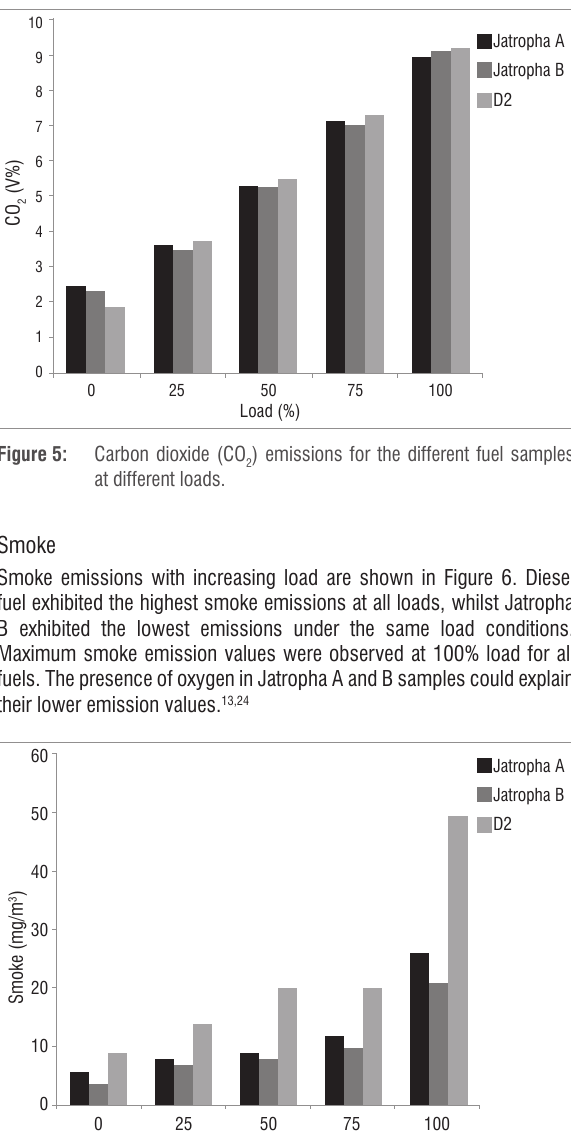
Figure 7 indicates the peak cylinder pressure for different fuels at different engine load conditions. Figure 8 illustrates the variations